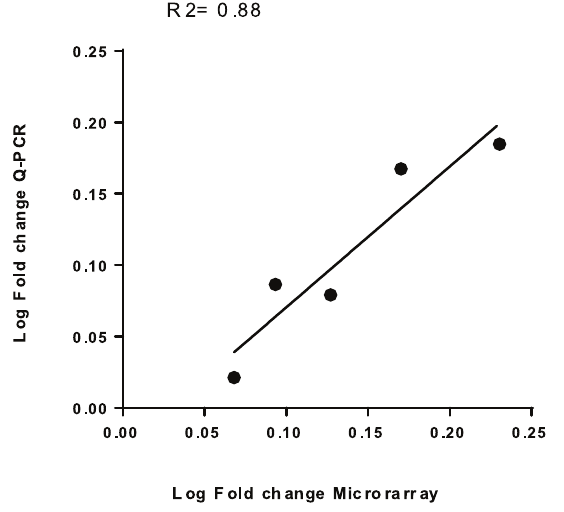
Figure 2. Comparison of gene expression measurements by microarray hybridization and quantitative real-time PCR. Log- transformed (in base 10) fold change values of the Q-PCR data (y-axis) were plotted against the log-transformed fold change values of microarray data (x-axis). The coefficient of determination (R 2) is given. doi:10.1371/journal.pone.0066150.g002 PLOS ONE |